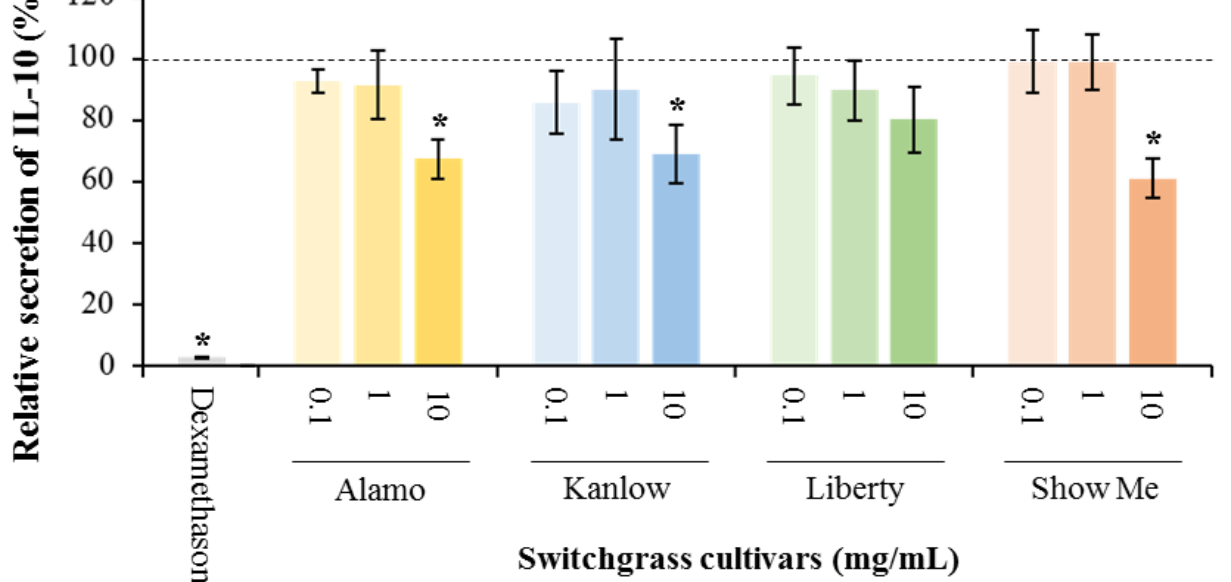
Figure 3. Effect of the switchgrass extracts on the expression of IL-8 in the U-937 model system. (*) Significant decrease ( p < 0.01) compared to the control cells without the extract. Mean ± SEM.